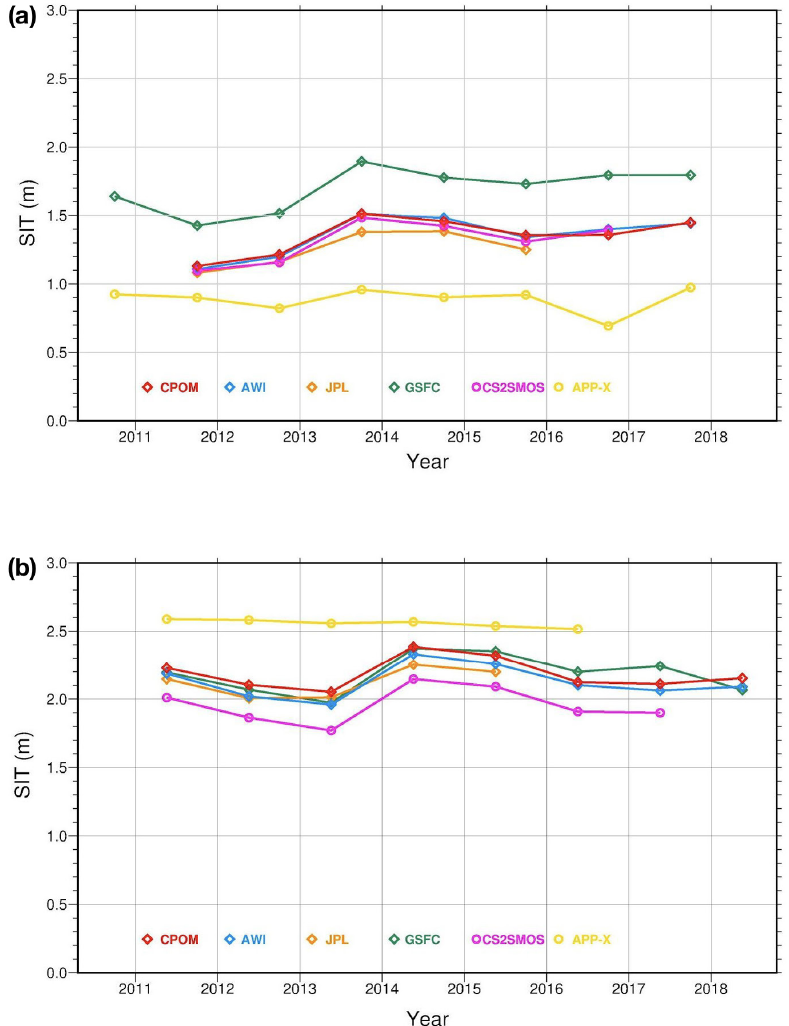
Figure 6. Time series of seasonally averaged sea ice thickness for (a) October–November and (b) March–April, over the central Arctic (regions 1–6) during the period 2010–2018, subject to data availability (Table